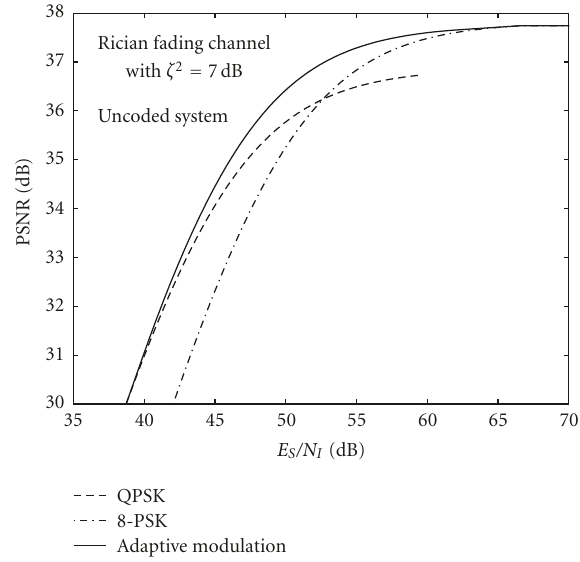
Figure 9: PSNR as a function of E S /N I in dB for 2-layer system with adaptive modulation scheme without channel coding for Ri- cian fading channel with ζ 2 = 7dB. Fixed symbol transmission rate r S = 128Ksps.